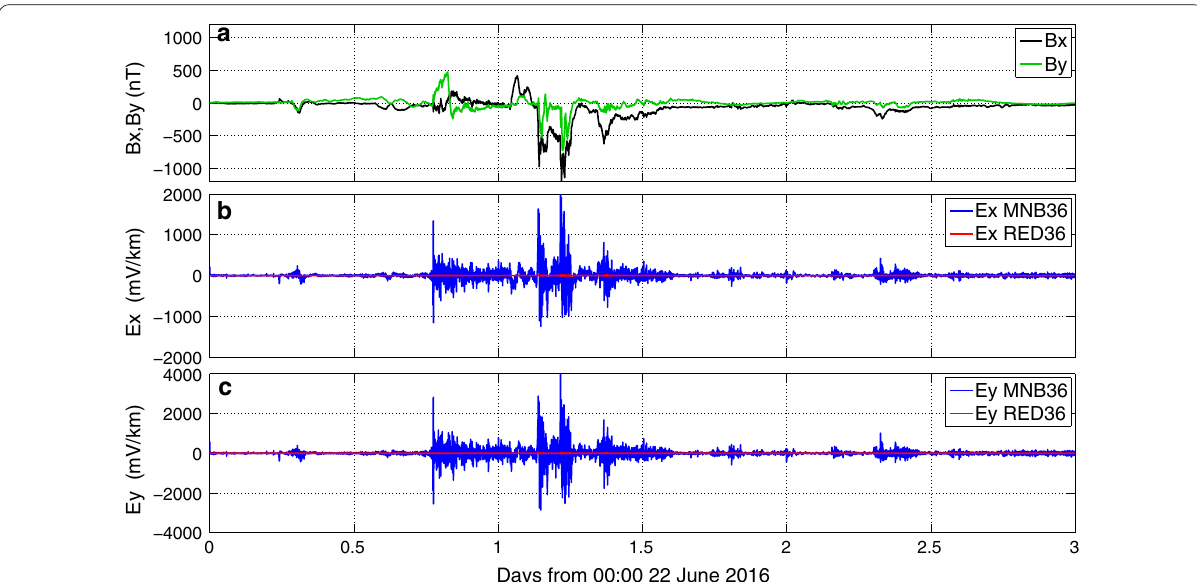
Fig. 4 Time series for geomagnetic fields at the Brandon (BRD) Magnetic Observatory for the June 22, 2016, storm for 3 days beginning at 00:00 June 22, 2016, and corresponding estimated geoelectric fields. a 1 s resolution geomagnetic field B x ( t ) (black) and B y ( t ) (green) in nT defined relative to a constant baseline, b estimations of the geoelectric field E x for EarthScope impedance MNB36 (blue) and RED36 (red) in mV/km, c equivalent time series to ( b ) for estimated E y